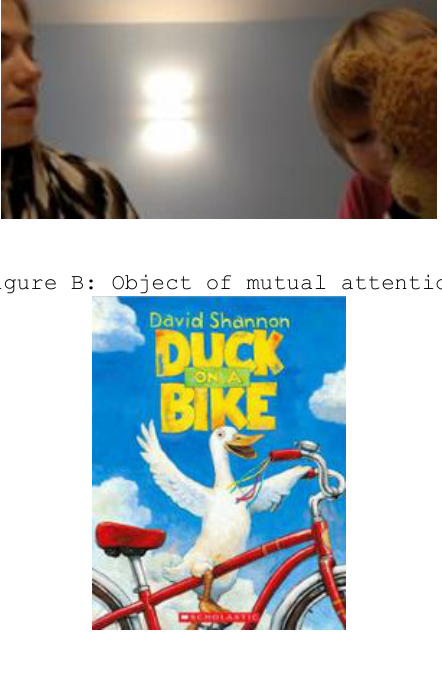
Figure A: Left to right: Tutor (T), Tutee (S), Mr. Bear